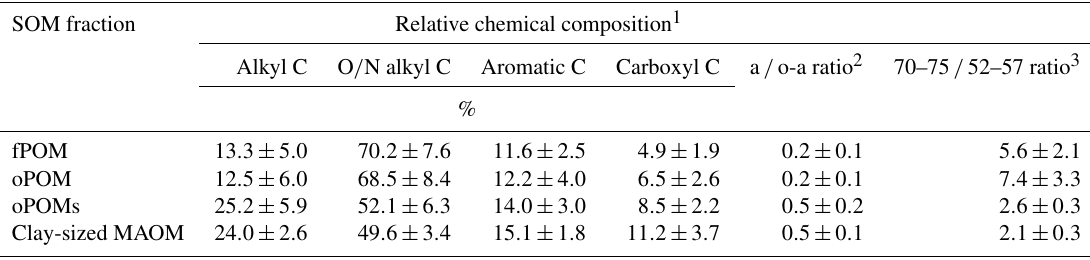
Table 2. Relative chemical composition of SOM fractions obtained by 13 C CP-MAS NMR spectroscopy and decomposition proxies (a / o-a ratio and 70–75 / 52–57 ratio). Given are mean values and the standard deviation of free (fPOM), occluded (oPOM) and small occluded (oPOMs) particulate organic matter and of clay-sized mineral-associated organic matter (MAOM). SOM fraction